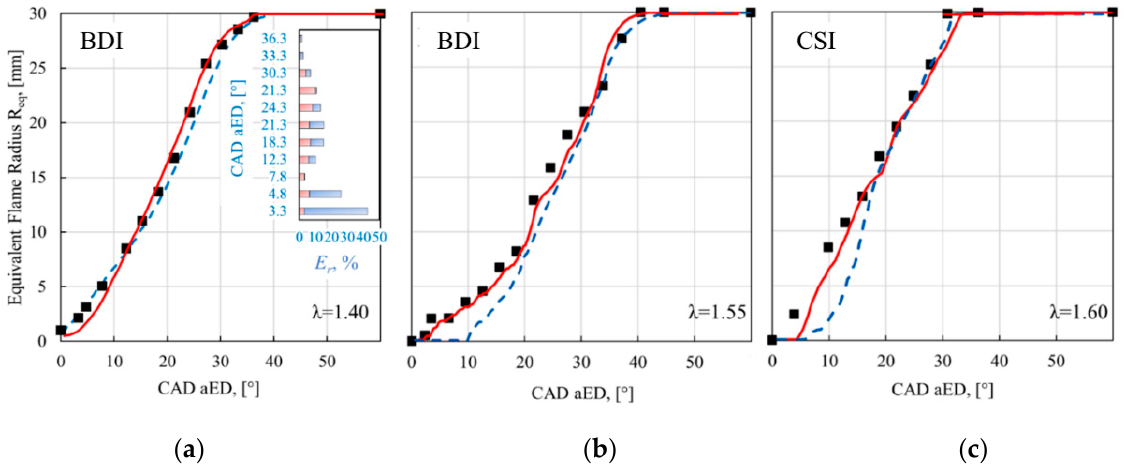
Figure 12. Evaluation of the R eq trends, averaged over 63 cycles, in the three operating conditions analyzed, i.e. ( a ) λ =1.4, ( b ) λ =1.55 and ( c ) λ =1.6.